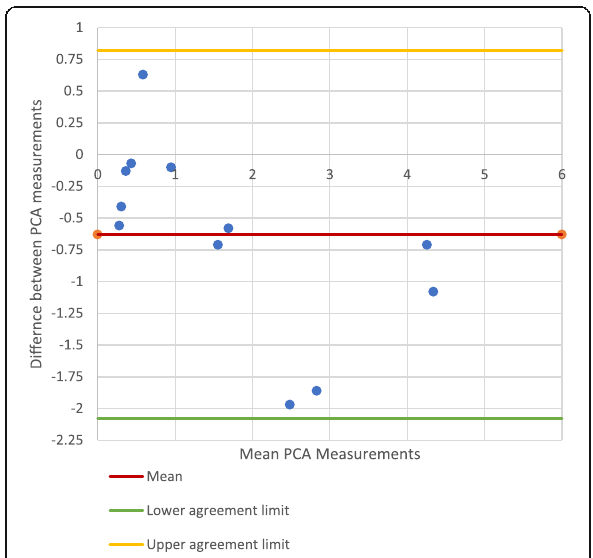
Anatomical vs . mechanical axis PCA measurements on CT images The Bland-Altmann plot comparing the PCA measure- ments from anatomical vs . mechanical axis CT images